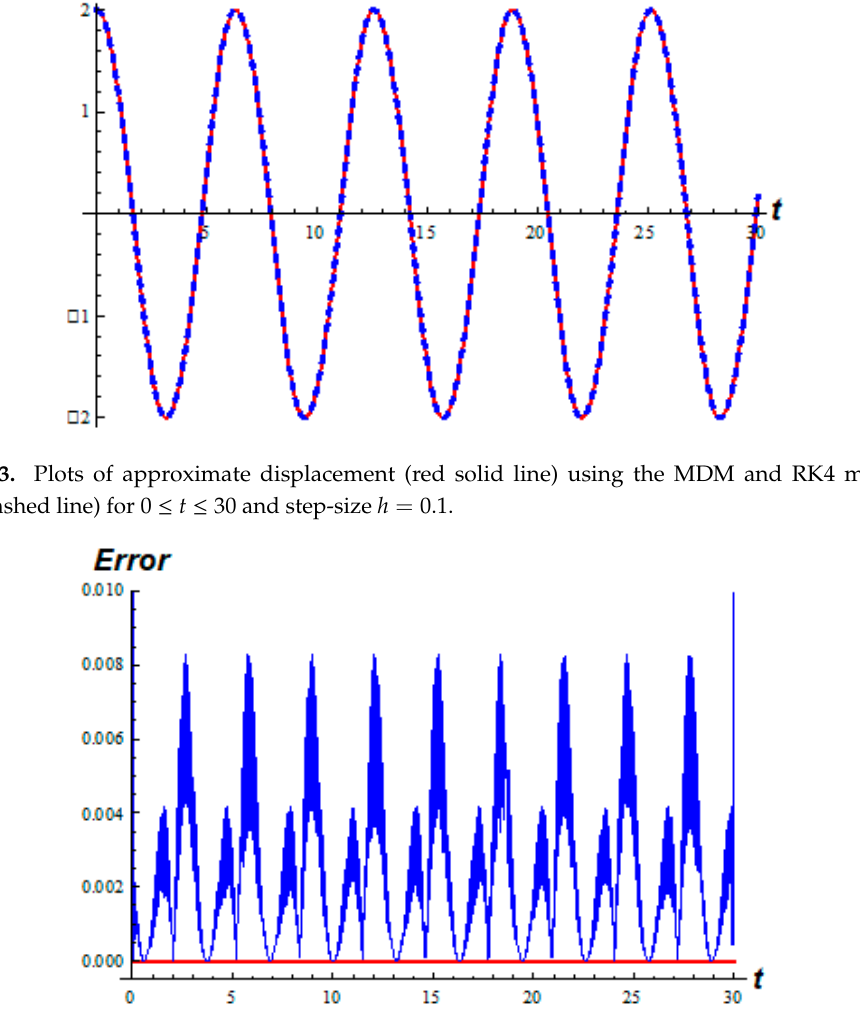
cycle in the phase plane. Figure 5 represents the phase plane diagrams for van der Pol oscillator at ε = 1 and the step-sizes h = 0.1 and h =